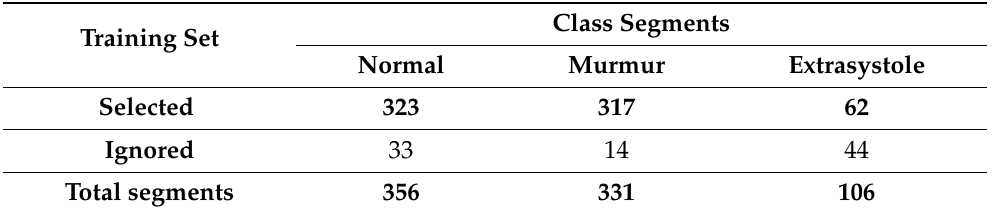
Table 3. Overview of selected PCG segments according to each class.